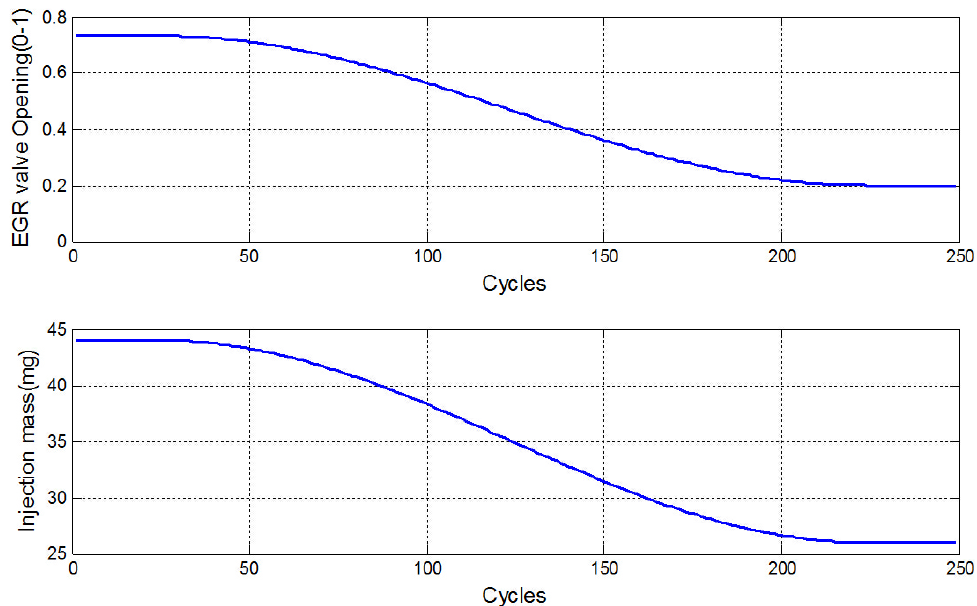
Figure 5. EGR valve opening and injection mass for model validation.